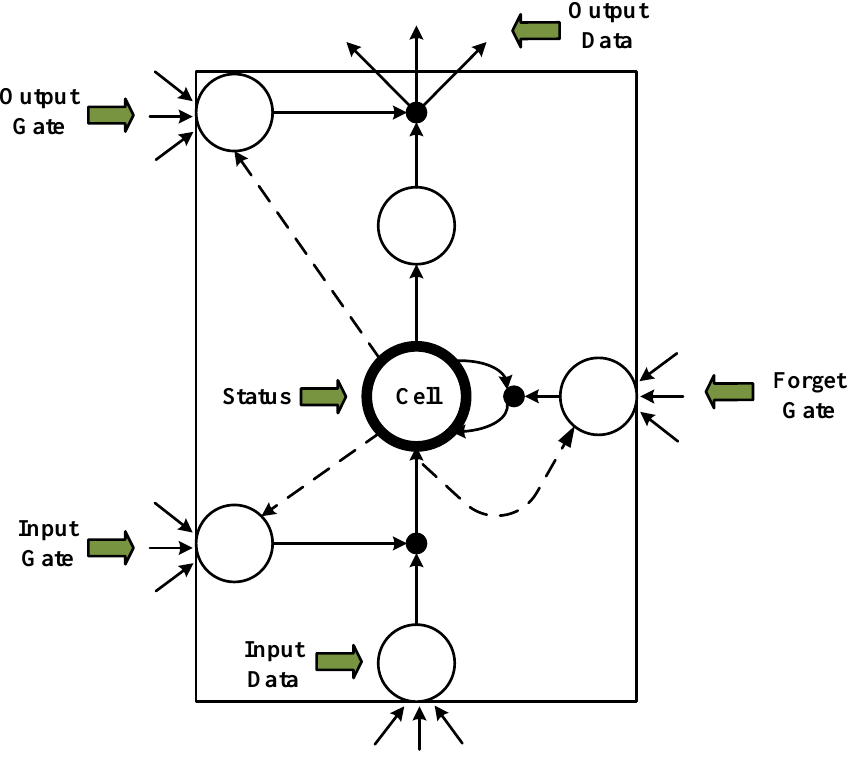
Figure 3. Long short-term memory (LSTM) cell unit structure diagram.